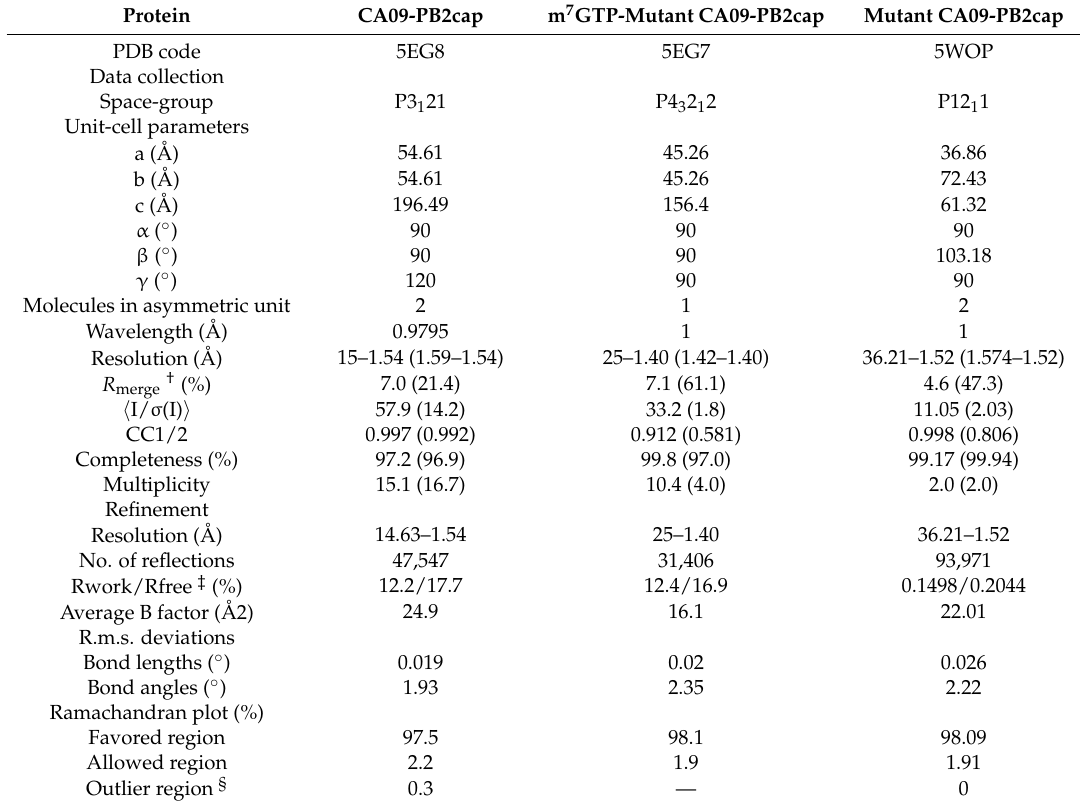
Table 1. Data collection, processing, structure solution, and refinement (values for the outer resolution shell are given in parentheses)